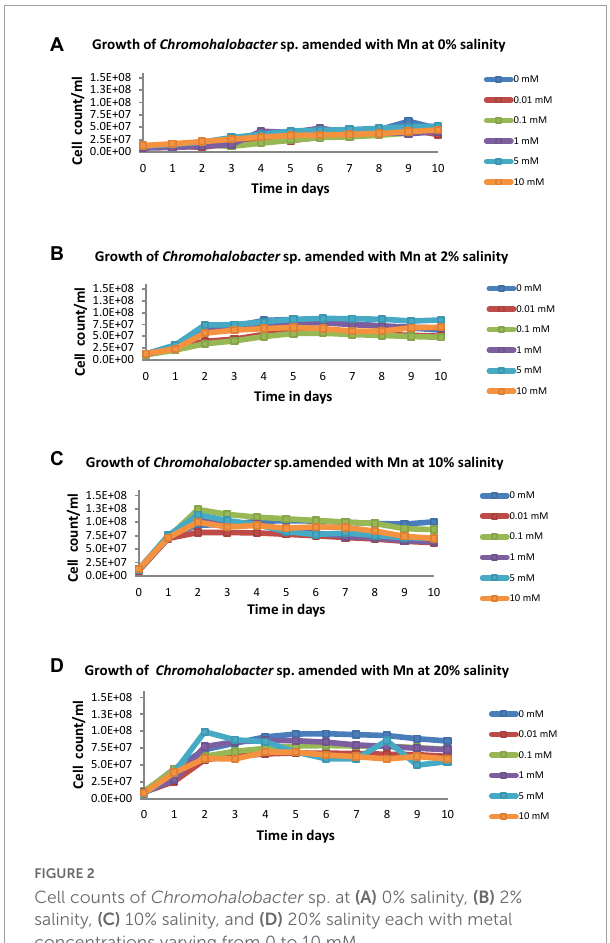
FIGURE2 Cell counts of Chromohalobacter sp. at (A) 0% salinity, (B) 2% salinity, (C) 10% salinity, and (D) 20% salinity each with metal concentrations varying from 0 to 10 mM.